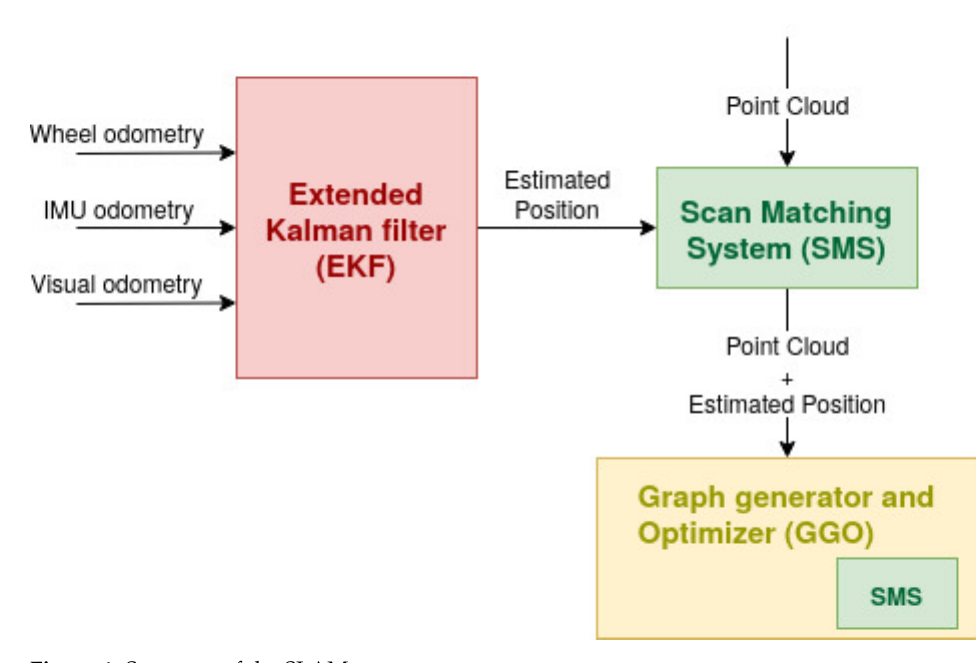
Figure 1. Structure of the SLAM